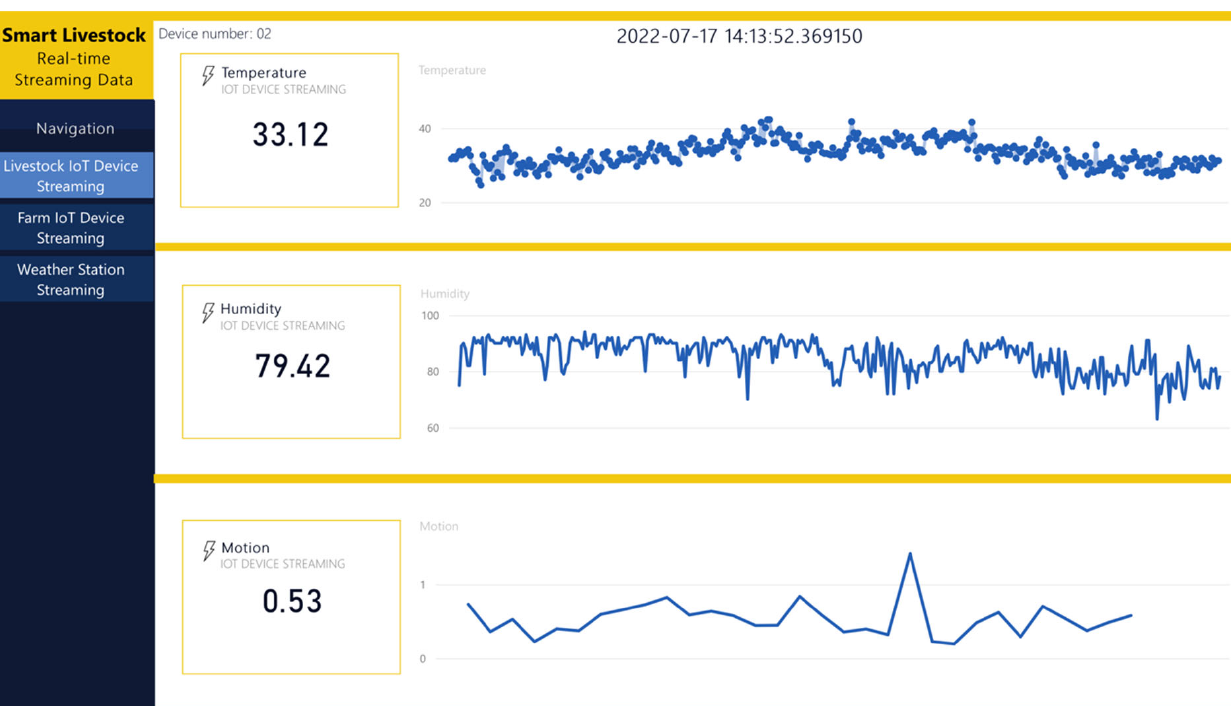
Figure 15. Machine learning model visualization.